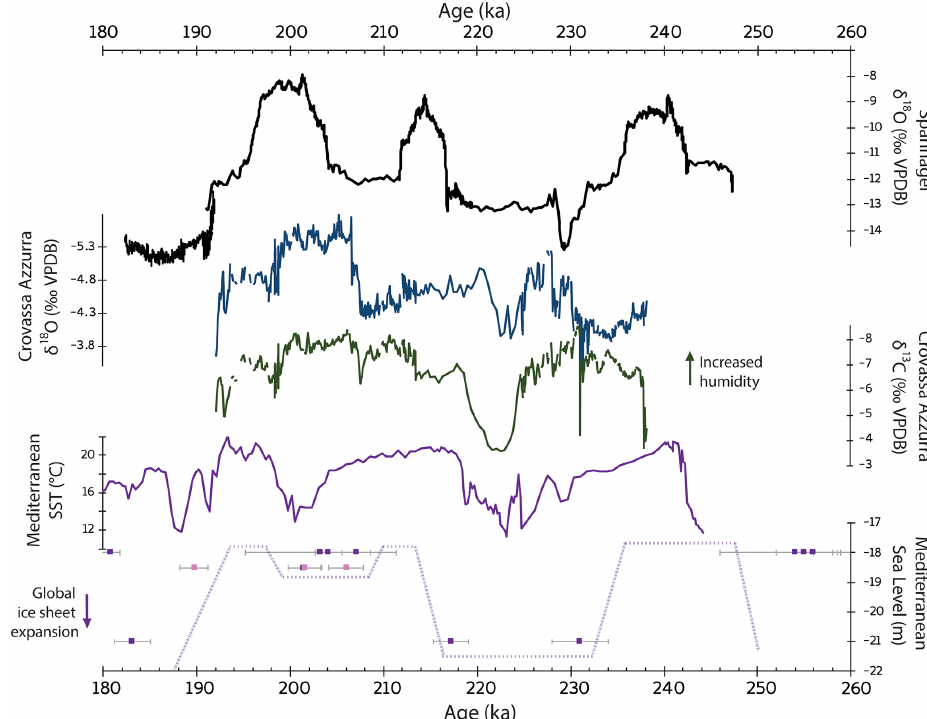
Figure 5. MIS 7 records from the circum-Mediterranean region. Spannagel Cave δ 18 O (black; this study), Crovassa Azzurra (Sardinia, Italy) δ 18 O (blue) and δ 13 C (green) (Columbu et al., 2019), western Mediterranean SST (Martrat et al., 2004), and Mediterranean sea- level reconstructions (purple; Dutton et al., 2009) (pink; Bard et al., 2002). Purple dashed lines are for visual aid only; absolute sea levels are unknown. Spannagel δ 18 O events that are decoupled from Mediterranean temperatures and humidity records represent evidence for temperature-driven δ 18 O excursions in the Austrian Alps, as opposed to changes in the proportion of Mediterranean-sourced moisture arriving at our study